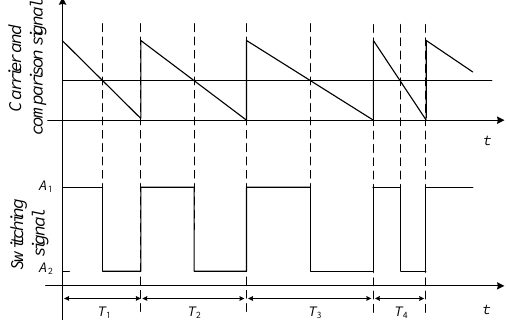
Figure 9. Principle of continuously chaotic modulation.